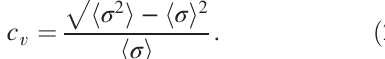
FIG. 7. (a) Cattle trade within Germany. Weighted edges correspond to directed trade relations within the year 2010, whereas the color indicates the accumulated number of traded animals. (b) Cattle trade within the federal states of Germany. We confine the underlying time-aggregated graph to the GSCC and visualize here only edges with a flux of at least 50 animals.